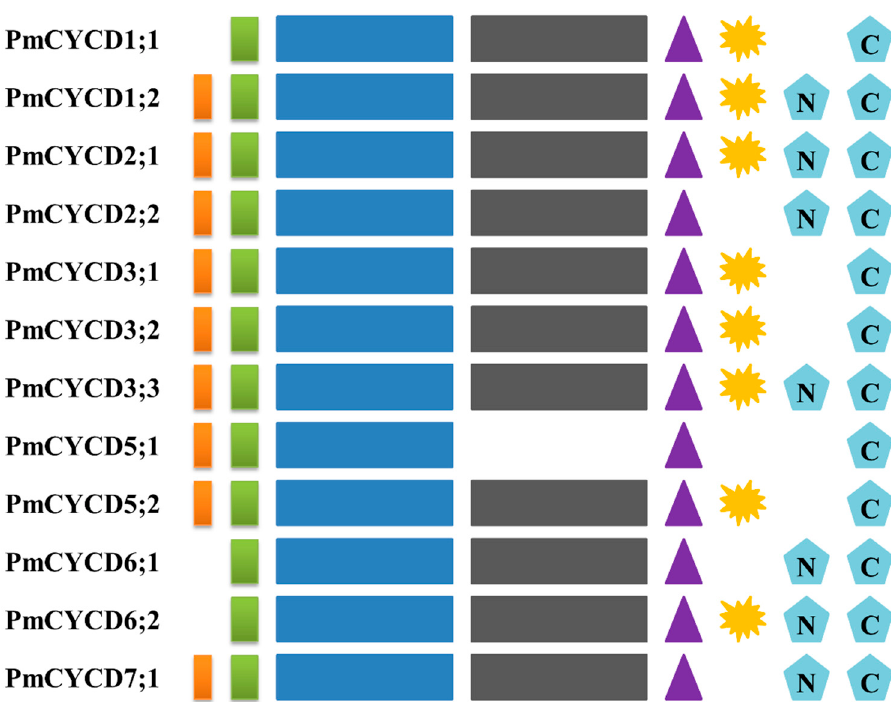
Figure 3. Characteristic cyclin domains and motifs found in P. mume CYCDs. LxCxE, cyclin box, cyclin ‐ N domain, cyclin_C domain, five non ‐ contiguous conserved amino acids, PEST sites, N ‐ glycosylation sites, C ‐ glycosylation sites.